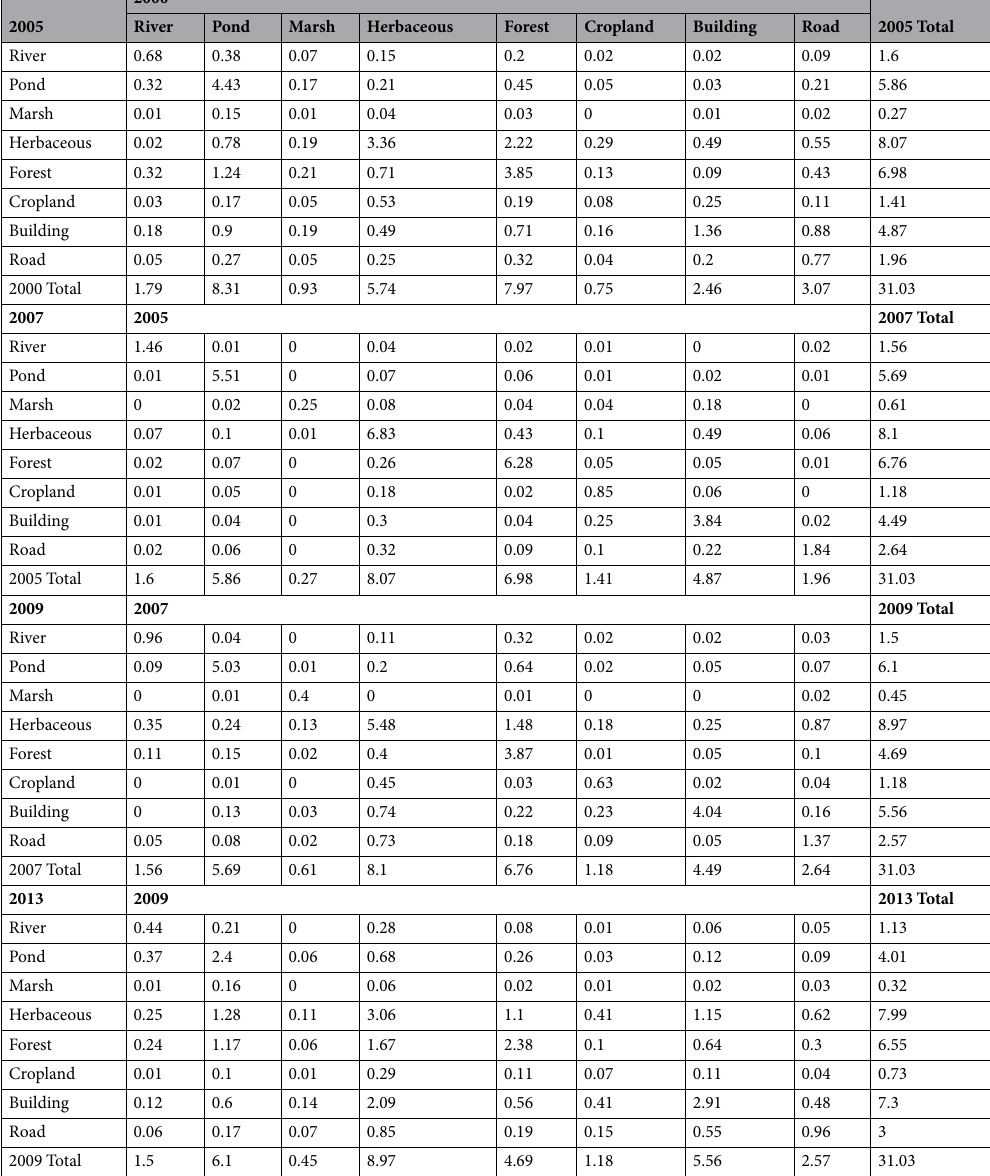
Table 3. Matrices of LULC and changes (km 2 ) from 2000 to 2005, 2005 to 2007, 2007 to 2009 and 2009 to 2013.